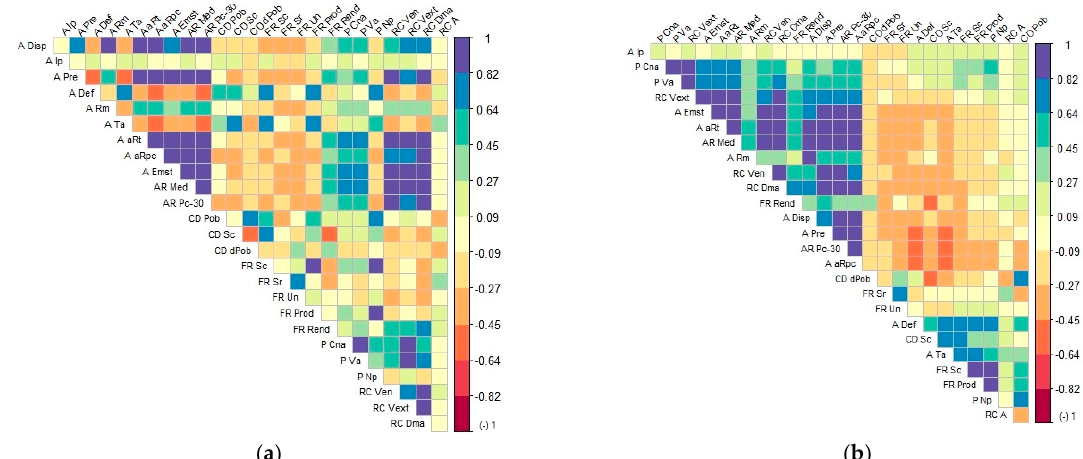
Figure 3. Correlation matrices developed from the interaction of the 26 variables selected and extracted from the SINA records. ( a ) The matrix on the left side represents the correlation of the variables in a non-grouped manner by affording the intensity. The color of the relationship scale indicates it; ( b ) the matrix on the right side is ordered according to the affinity between the intensity of the analyzed variables’ relationships.